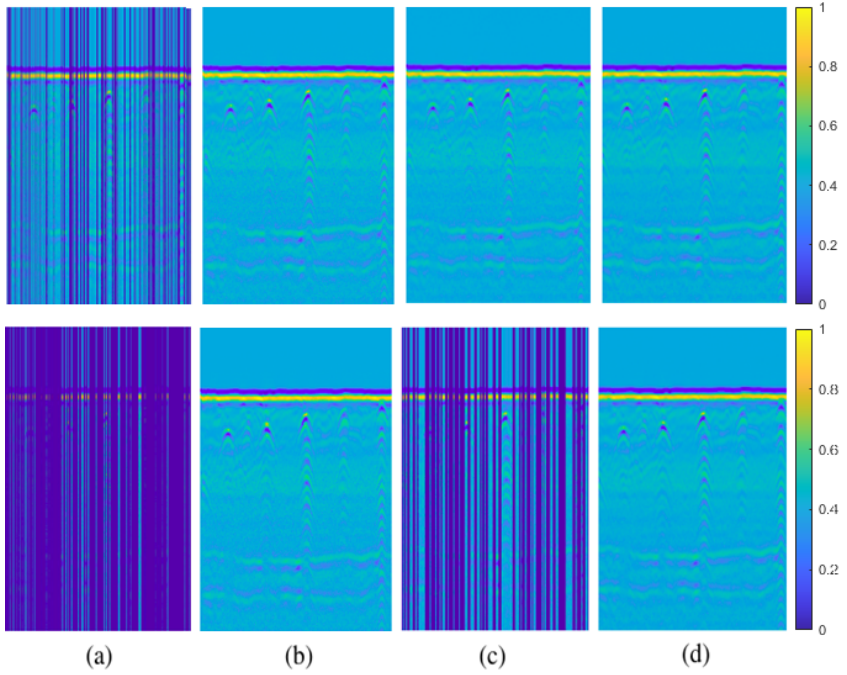
Figure 23. First row 30% and second row 50% column-wise missing data case for real data-II: ( a ) GPR image with missing entries, recovered images by ( b ) original GPR image, recovered images by ( c ) NNM, ( d )